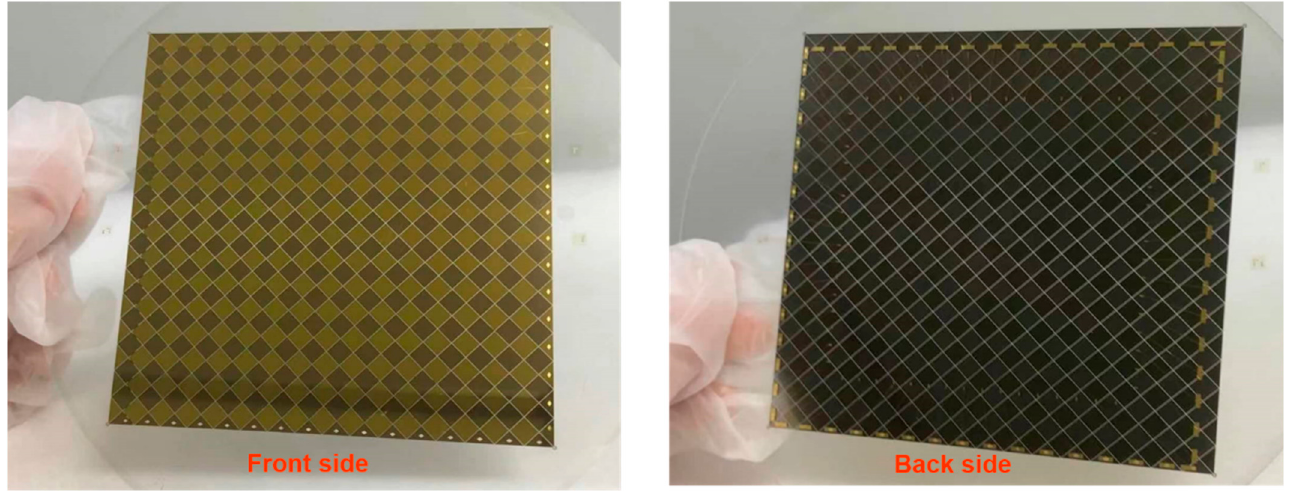
Electronics 2022 , 11 , x FOR PEER REVIEW Figure 8. Detector prototype with TGVs. Figure 8. Detector prototype with TGVs.